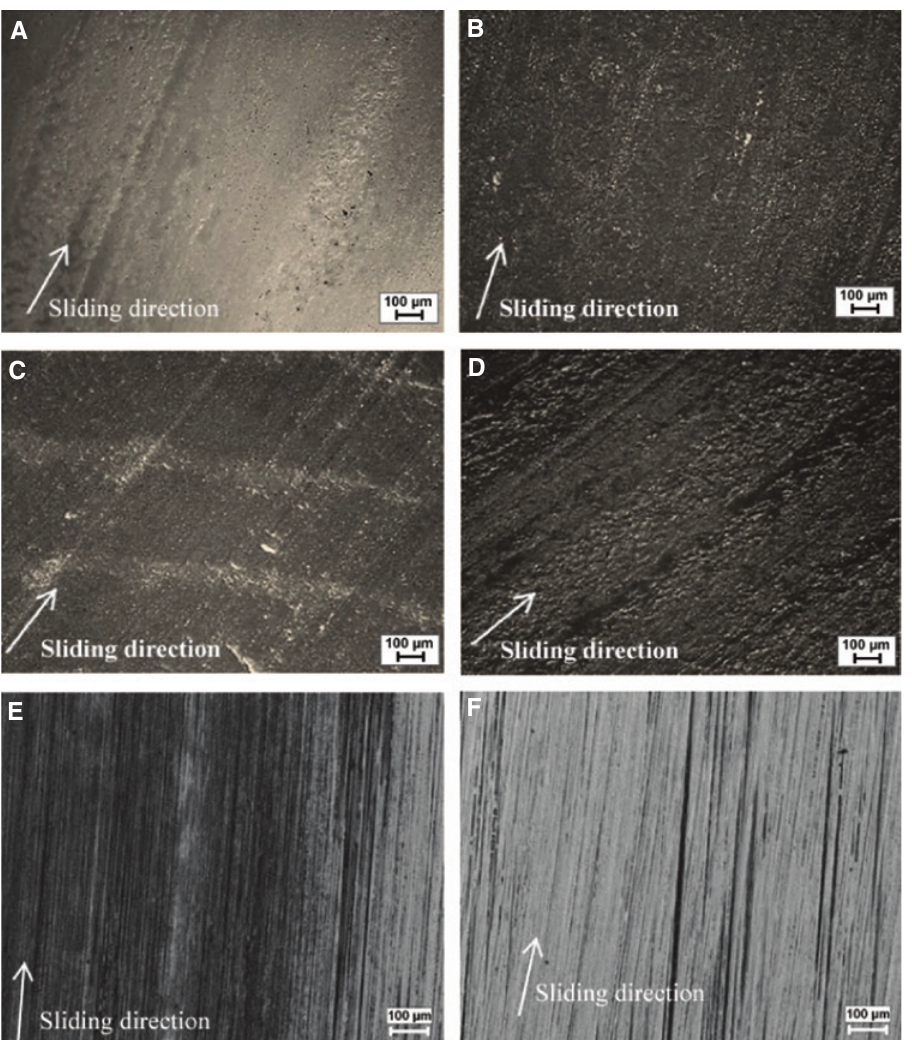
Figure 11: Optical micrographs of worn pin and disc surfaces of nanoclay epoxy composites at 0.4 m/s sliding speed and 15 N load condi- tions. (A) Worn pin surface of pure epoxy, (B) worn pin surface of 2.5 wt% nanoclay-filled epoxy composite, (C) worn pin surface of 5 wt% nanoclay-filled epoxy composite, (D) worn pin surface of 10 wt% nanoclay-filled epoxy composite, (E) worn disc surface of pure epoxy, (F) worn disc surface of 10 wt% nanoclay-filled epoxy